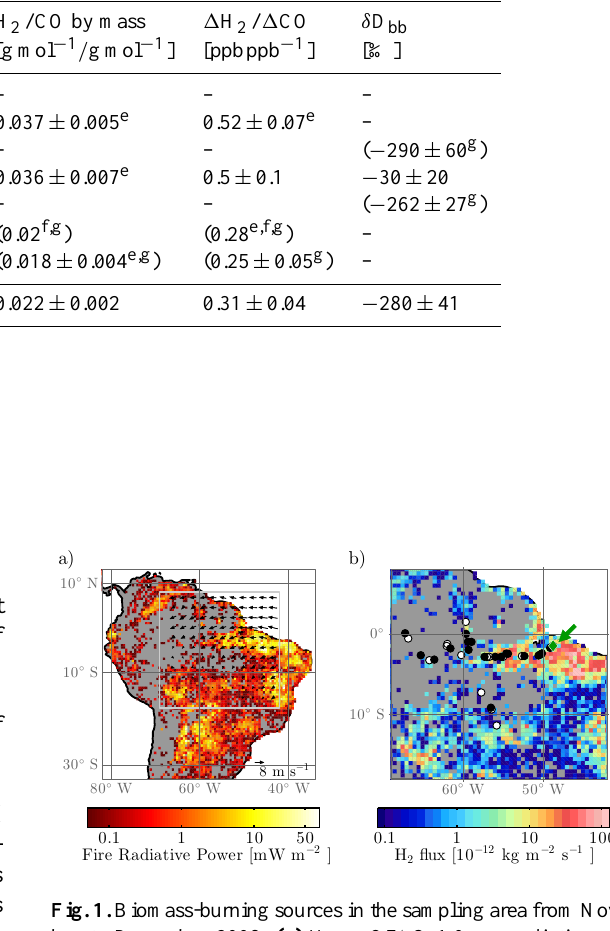
Several flight tracks span more than 2000 km of the Ama- zon Basin that were influenced by air masses from the re- gions of extensive biomass burning. Samples were taken in vertical profiles along the tracks from near-surface up to more than 4000 m a.s.l. in the atmospheric boundary layer and the lower free troposphere above. The samples that we analyse in this study are indicated by circles in Fig. 1b. Black circles indicate high-altitude samples (above 1100 m a.s.l.) and white circles low-altitude samples (below 1100 m